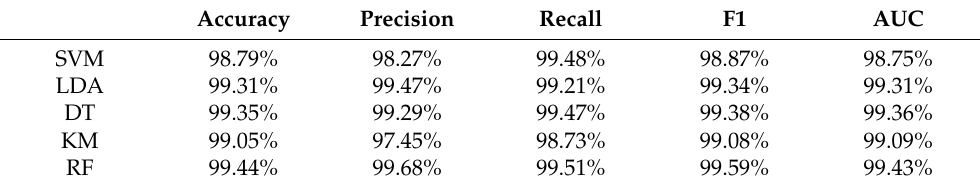
Table 6. Combination feature classification effect in time domain, frequency domain, and wavelet